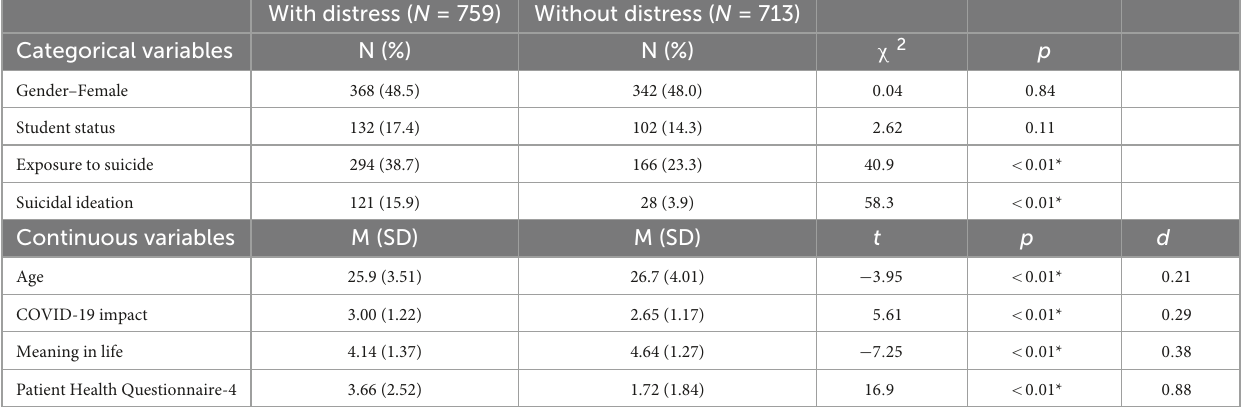
TABLE 3 Comparison of the profiles across participants with and without self-report distress in the past 4 weeks.